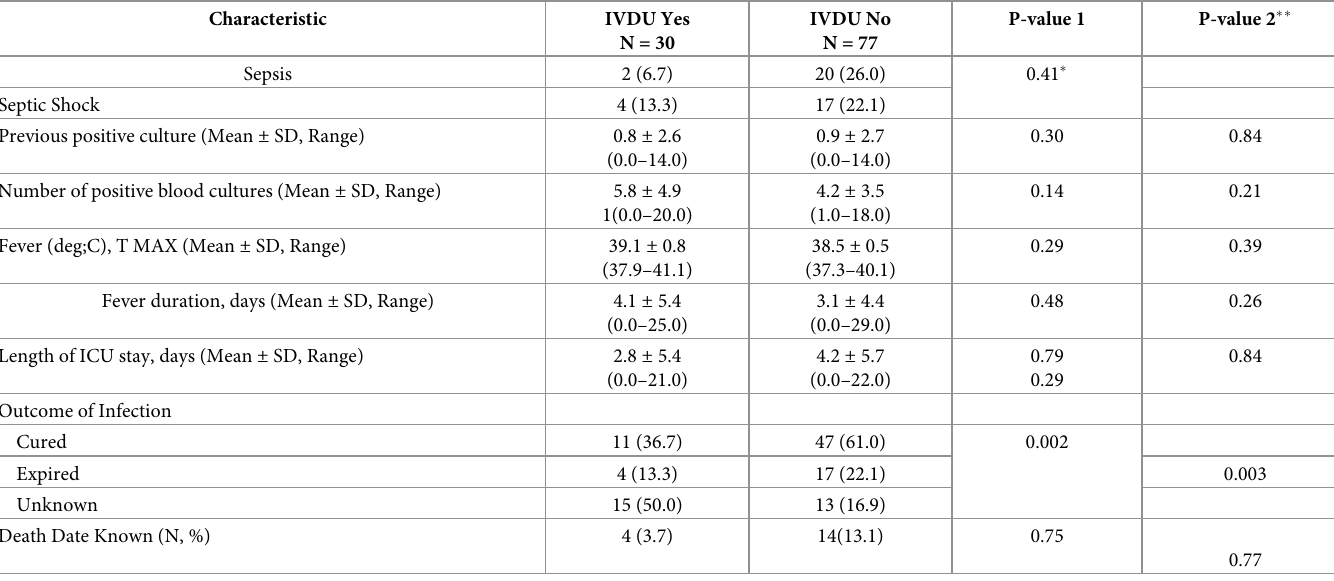
Table 6. Patient outcomes by IVDU” History.